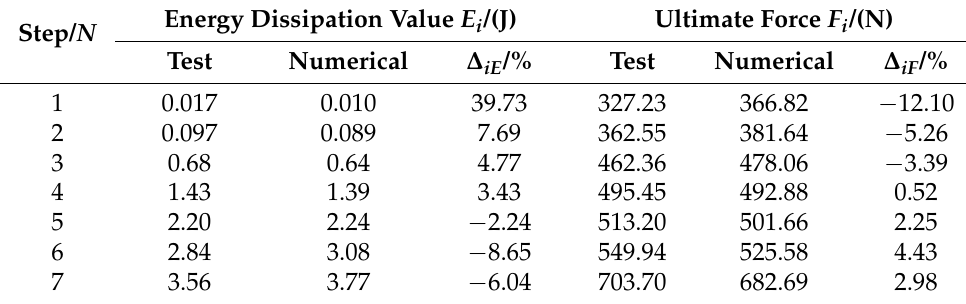
Table 3. Comparison of results under the strain amplitude.